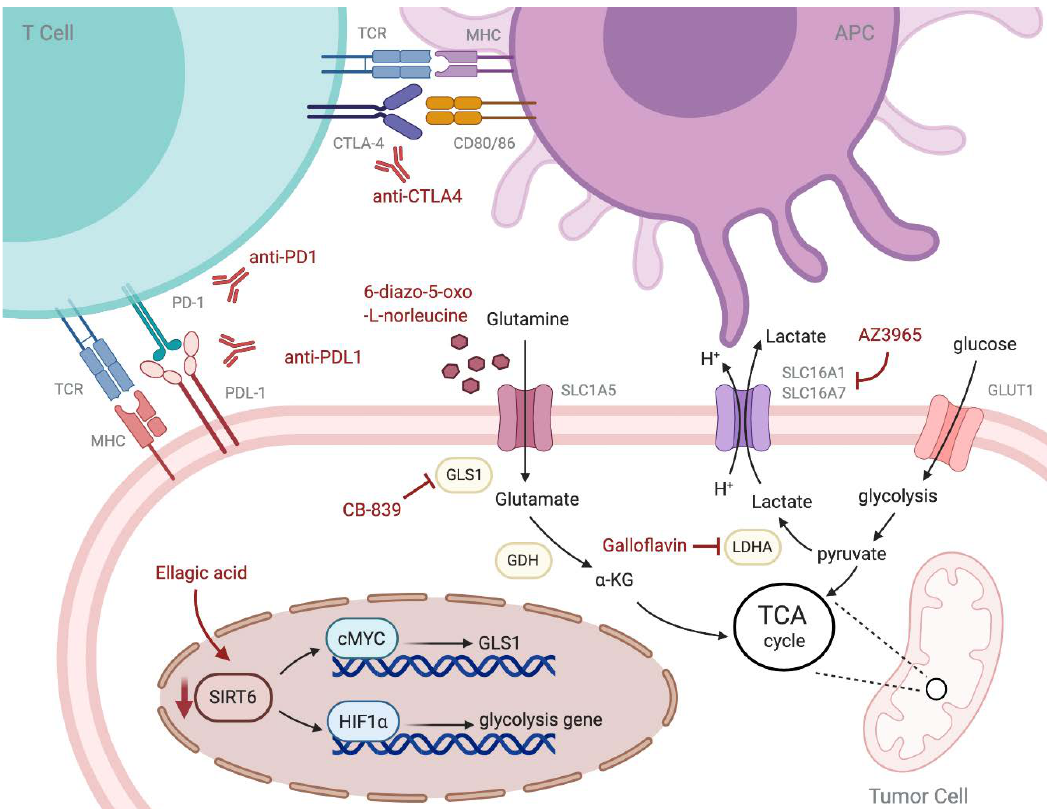
Figure 1. The immune interaction and metabolic character of tumor cells and the mechanism of